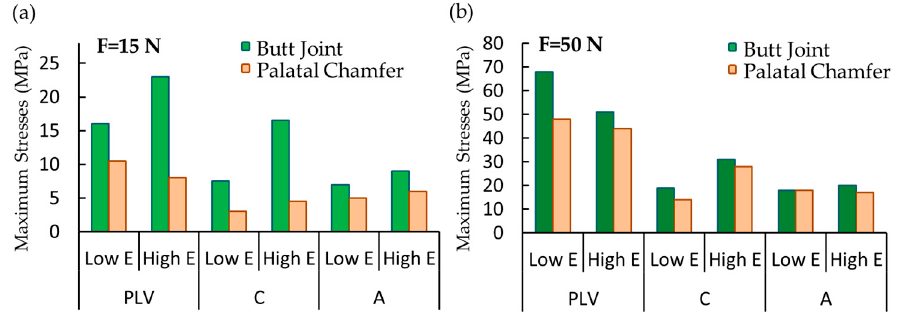
Figure 7. The maximum stress values in the porcelain laminate veneer (PLV), resin cement (C), and adhesive layer (A) for butt joint and palatal chamfer preparations in response to ( a ) a 15 N force for protrusive movement and ( b ) a 50 N for the tearing function.